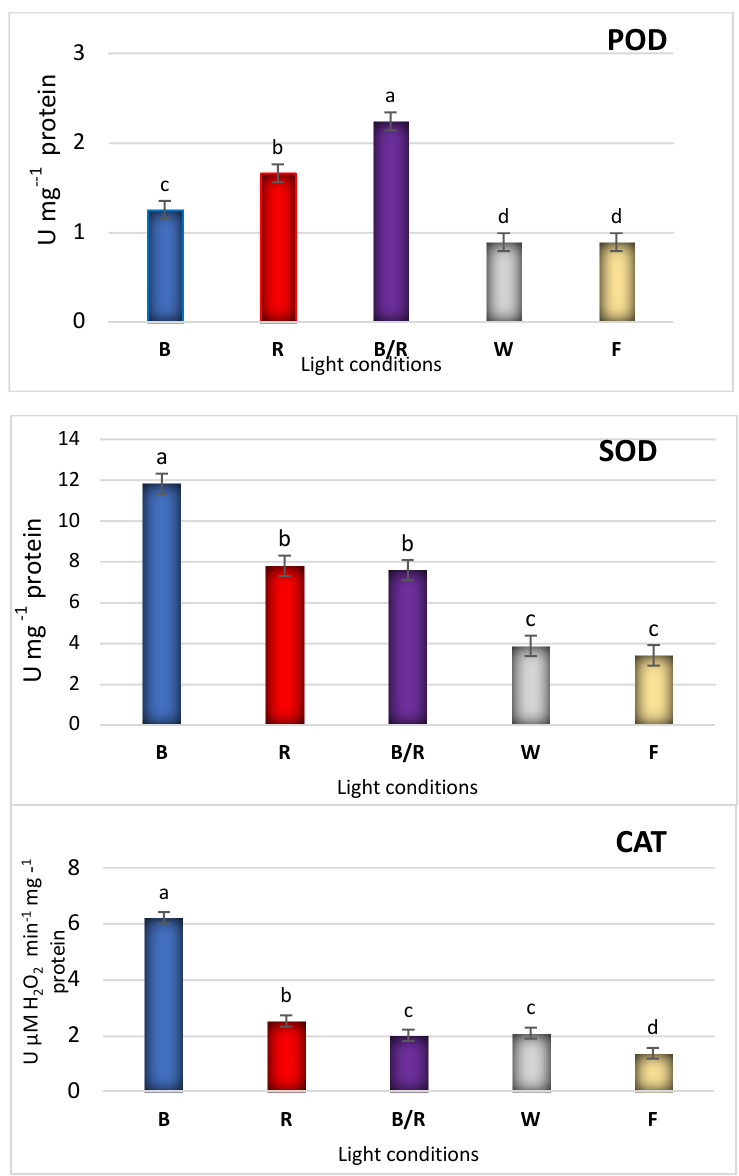
Figure 7. The effect of light conditions: ( B ) blue, ( R ) red, ( B/R ) blue/red, ( W ) white, ( F ) fluorescent on the antioxidant enzyme (POD—peroxidase, SOD—superoxide dismutase, CAT—catalase) activities in shoots of D. forrestii . The values represented means ± SE of three independent experimental replicates. The means marked with various letters for the same parameter were different at p < 0.05 according to one way ANOVA test followed by the post-hoc Tukey’s